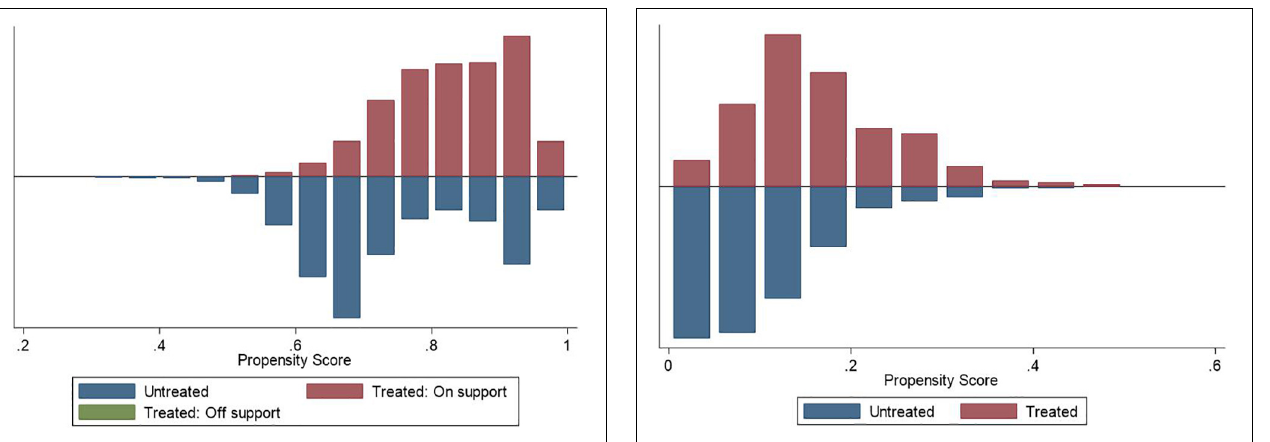
FIGURE 1 | Density distribution of treated and untreated observations (Fertility ≥ one child).